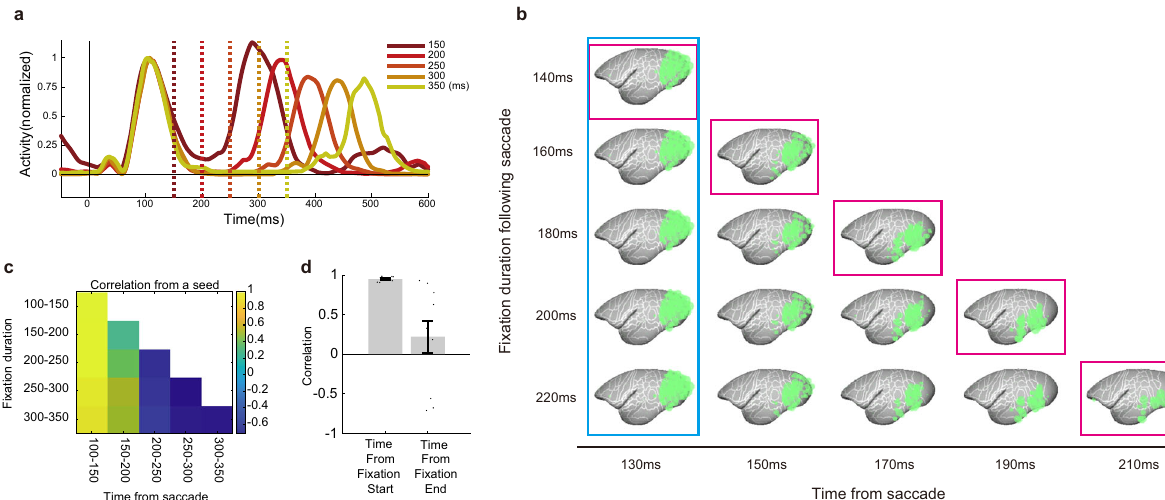
Fig. 9 Parallel computation for saccade generation: distinctive activity pro fi les at fi xation termination. a Time course of whole-brain activity at different fi xation durations. Regardless of fi xation duration, which is the time available for determining the next saccade, brain dynamics were consistent (0 – 200 ms after saccade onset), i.e., the timing when whole-brain activity returned to background levels remained at ~200 ms. b Activity patterns for saccades with different fi xation durations. Even when fi xation duration was very short, the activity wave did not propagate rapidly across the cortex; instead, the activity dynamics were very similar within the same time range from saccade, regardless of the following fi xation duration (blue box). On the contrary, the activity patterns when fi xation terminated were drastically different across fi xation duration (magenta box). c Example of the correlation matrix of the cortical activity fi ngerprint. The seed was the top-left image of ( b ). Again, activity was similar at the same time range after the saccade, rather than the time before fi xation termination. d Mean correlation for activity in the same time range just after the saccade (blue box in b) and in the same time range just before fi xation termination (magenta box). Dots show individual pairwise correlation The brain state of fi xation termination that is drastically different according to time can be used to determine the next saccade target ( t (18) = 3.6, P < 0.001), suggesting parallel computation of saccade